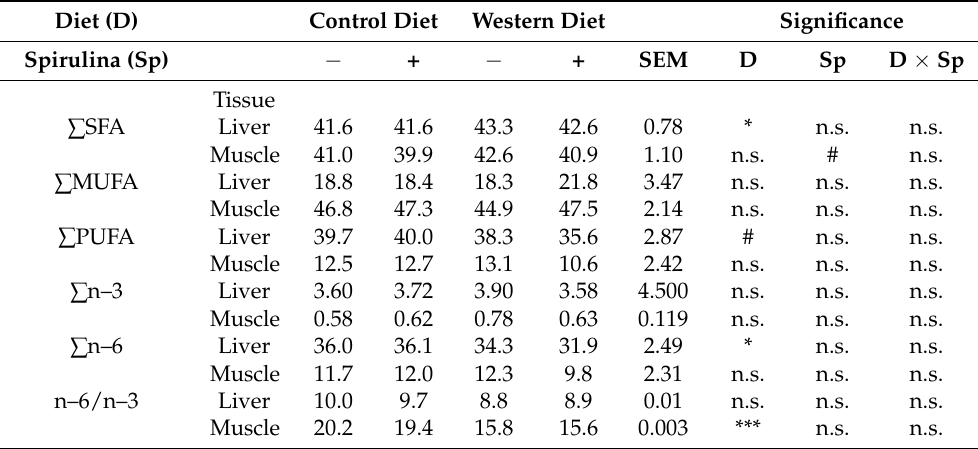
Table 4. Effects of Western diet and spirulina supplementation on the main FA groups present in liver and skeletal muscle of sows (g/100 g total FA). Diet (D) Control Diet Western Diet Significance Spirulina